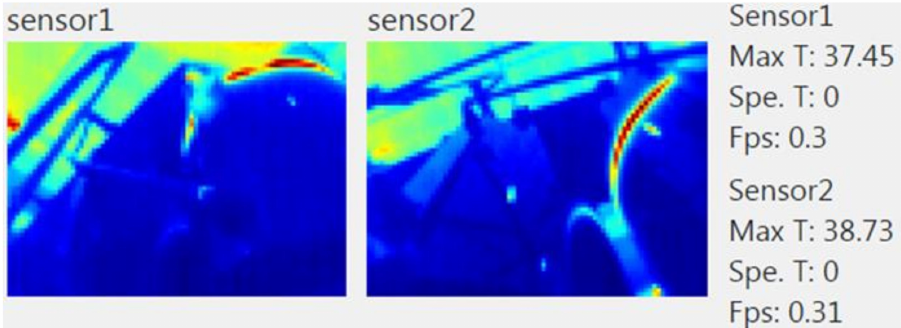
Figure 7. ITSC observed by the sensor. Max T is the highest temperature in the